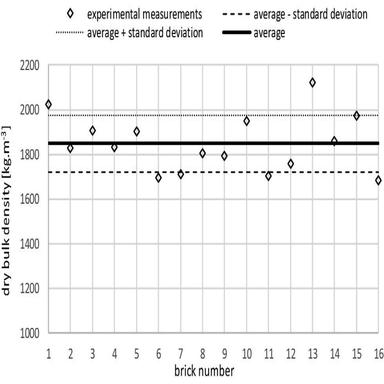
Dry bulk density of the raw perforated bricks.